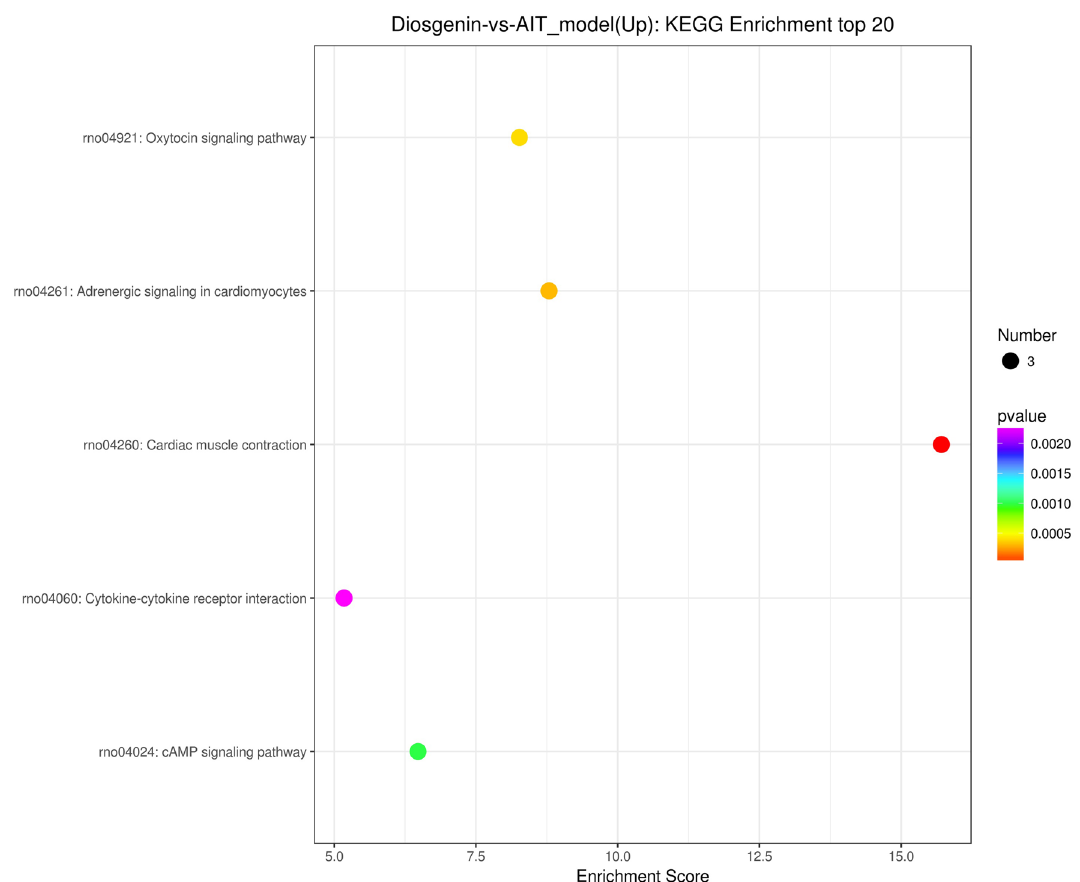
Figure 5. Bubble diagram of top 20 KEGG enrichment analysis pathways. Caption: The x-axis displays the enrichment score. The larger the bubble, the greater the number of differential protein-coding genes. The color of the bubble changes from purple-blue-green–red. The smaller the enrichment P-value, the greater the significance.